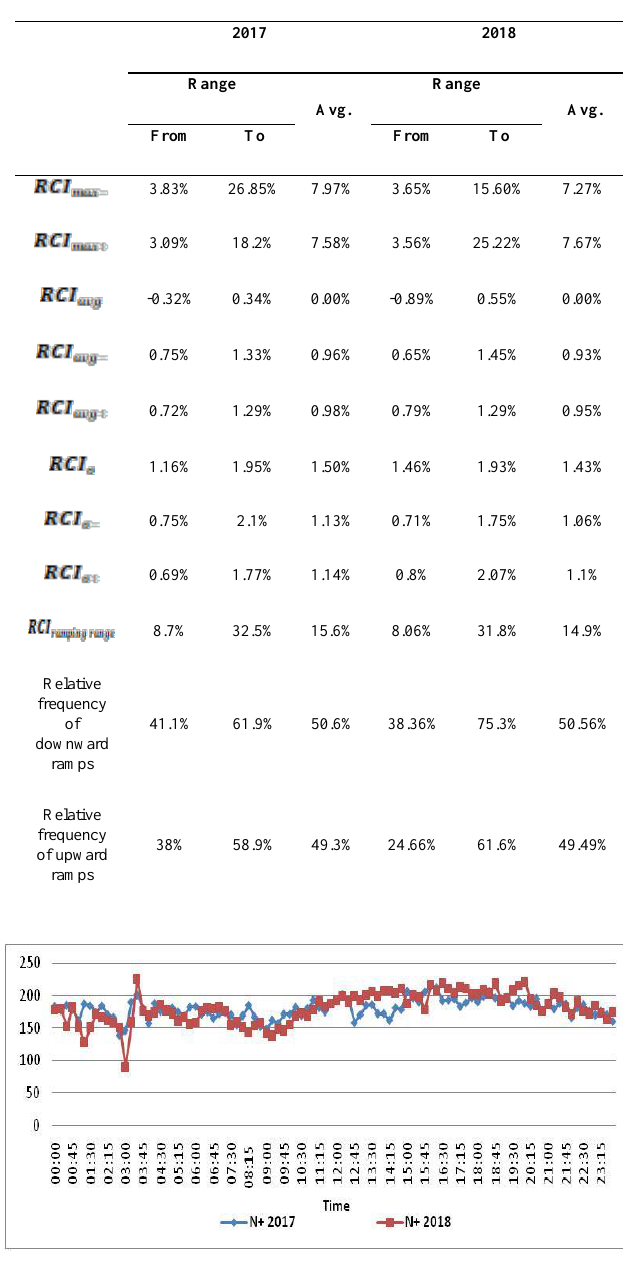
Figure 6. Comparison between numbers of upward power ramps in 15 min interval at each observation time t for the years 2017 and